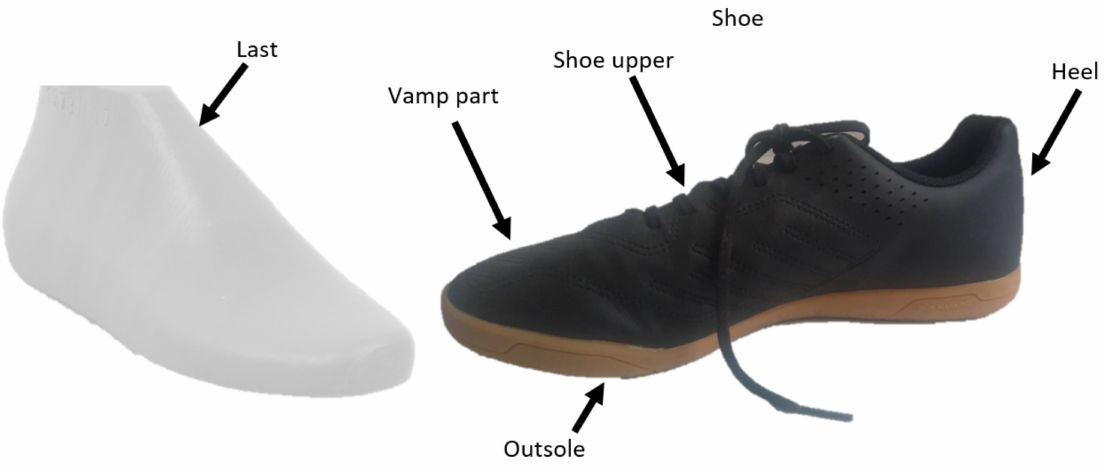
Figure 1. The basic parts of the